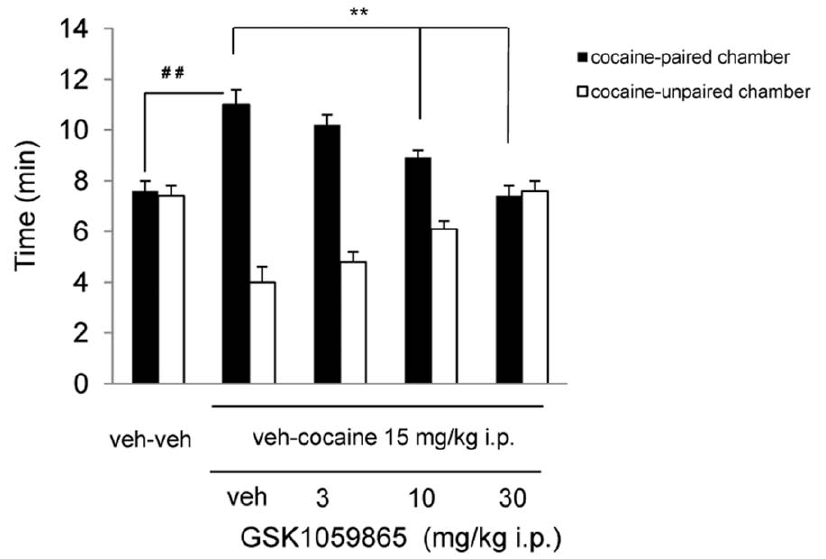
Figure 7. Effect of the OX1R antagonist on cocaine induced CPP. Effect of vehicle (veh) or GSK1059865A on the expression of cocaine- induced CPP response. Acute administration of 10 and 30 mg/kg i.p. of GSK1059865 significantly decreased the expression of the CPP response to cocaine compared to vehicle at 10 mg/kg and 30 mg/kg i.p. (** p , 0.01 vs. Vehicle; ANOVA and Student-Newman-Keuls test). Times spent in the cocaine-paired and cocaine-unpaired chambers on test day are shown as means 6 S.E.M. ( ## p , 0.01 versus Vehicle-Cocaine + Vehicle on test day, Student’s u npaired t test).